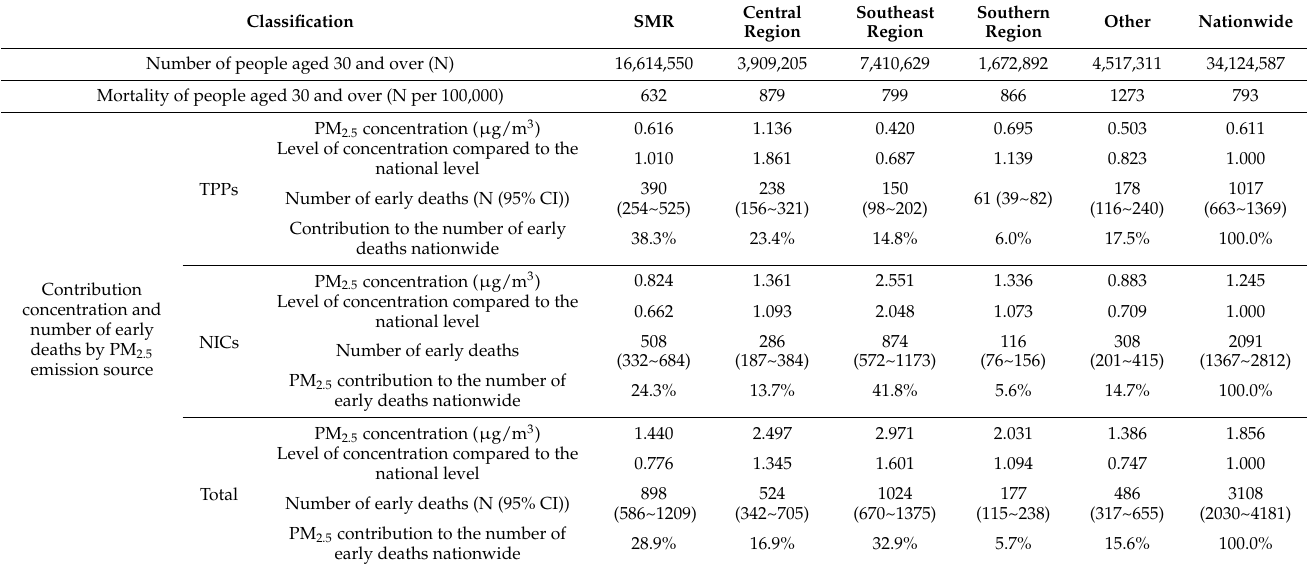
Table 4. Changes in PM 2.5 concentration for each ACZ and the attributable number of early deaths. Classification SMR Central Region Southeast Region Southern Region Other